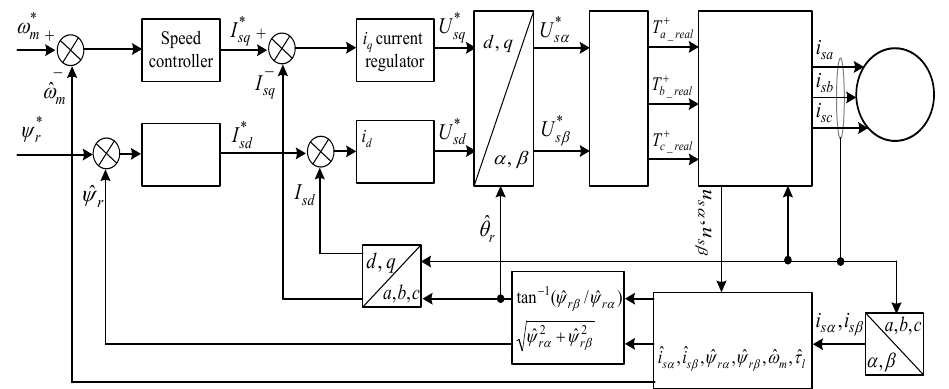
Figure 6. Block diagram of the sensorless control of the IM drives with EKF-based speed estimator.